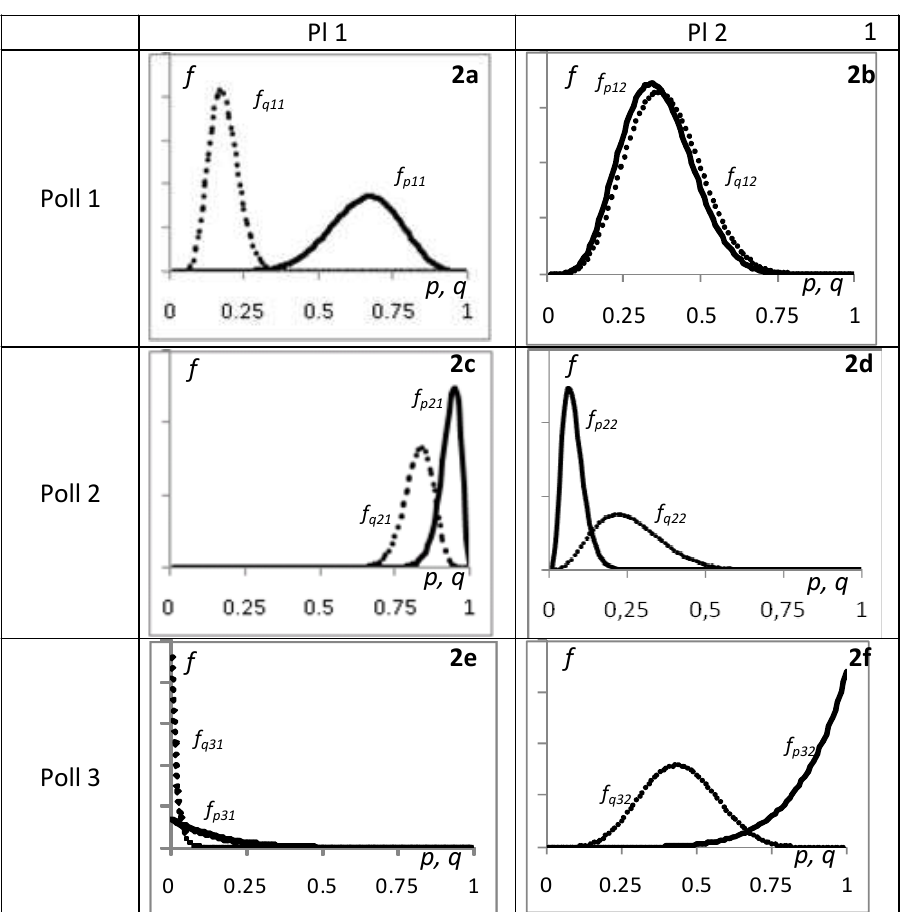
Figure 2a-f. Graphic display of eqs. 5 a and b for the data in Table 2, where the y-axis is the probability density for p and q, and the x-axis is the values of p and q (continuous line: function of p, dotted line: function of